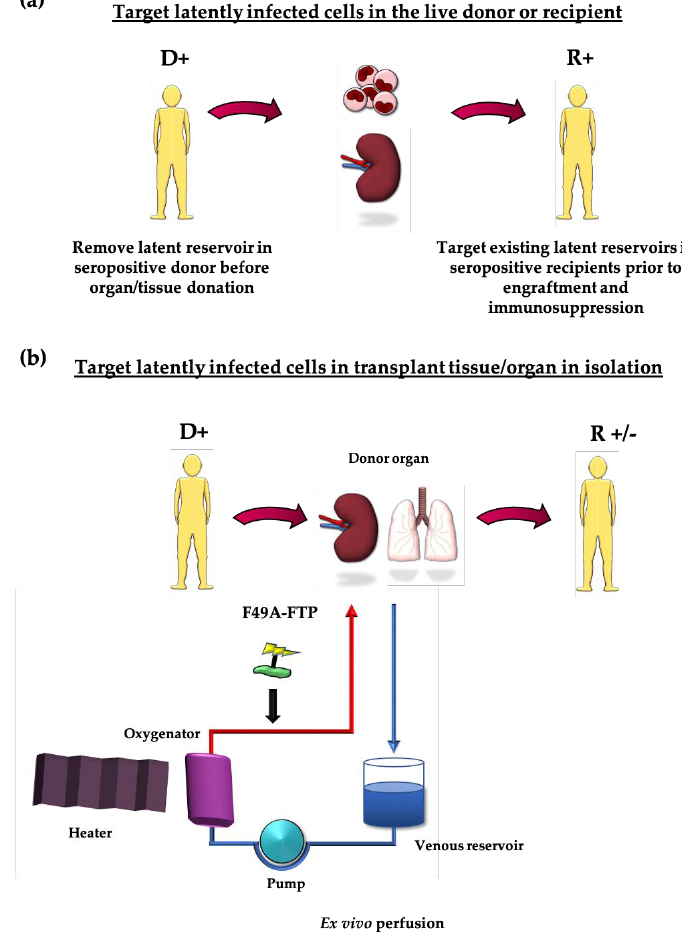
Figure 1. Opportunities for purging the latent reservoir ( a ) Seropositive donors could be treated before they donate organs/tissue to purge cells latently infected with HCMV. Seropositive recipi- ents could likewise be treated prior to immunosuppression to remove their own existing latently infected cells that could reactivate. ( b ) Organs could be treated in isolation in ex vivo